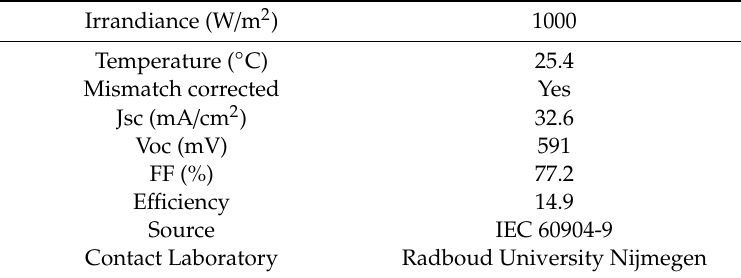
Table 2. Silicon solar cell